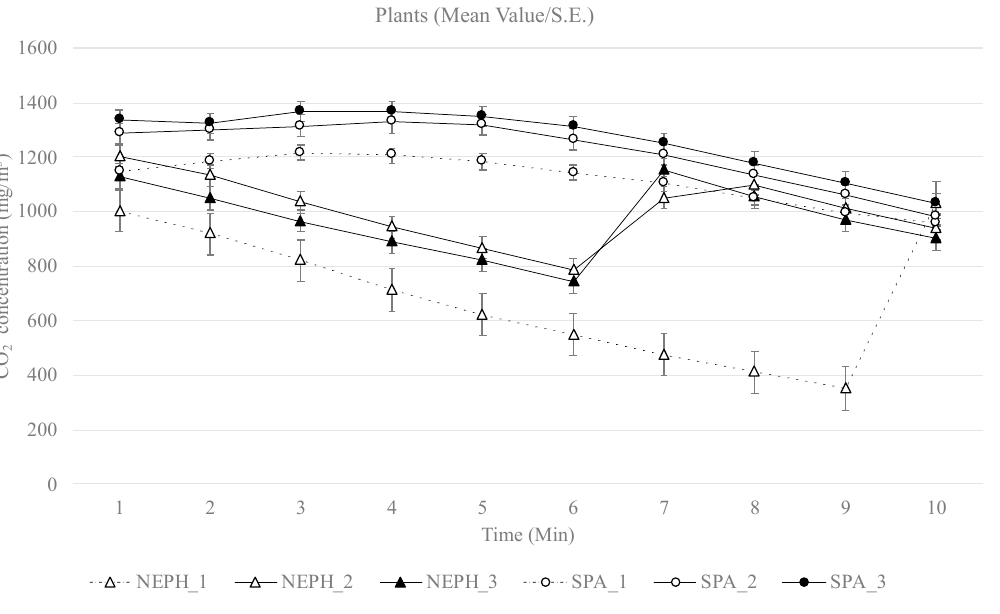
Figure 9. Depletion of formaldehyde (NEPH_1, NEPH_2, and NEPH_3) vs. depletion of CO 2 (CO2_1, CO2_2, and CO2_3): for the three Boston ferns. Data means ± SE, n = 3. 4. Discussion This study provides data for the characterization of the removal of formaldehyde by three different substrates and two different potted plants. Four series of zero measure- ments were executed to evaluate the setup. Two measurements of these series were exe- cuted with a plastic pot to evaluate the effect of this element in the depletion of the for- maldehyde inside of the chamber. As expected, once the plastic pot was placed in the chamber, the formaldehyde level was lower than the natural decay measured during the